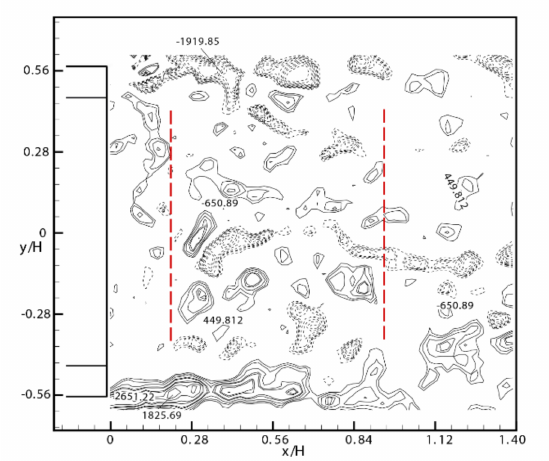
Figure 24. Iso-contours of instantaneous streamwise vorticity ω z in x–y plane at z/H = − 0.19. Minimum and incremental values of vorticity are ω z,min = − 650.890 s − 1 , 449.812 s − 1 , and ∆ ω = 253.948 s − 1 ,